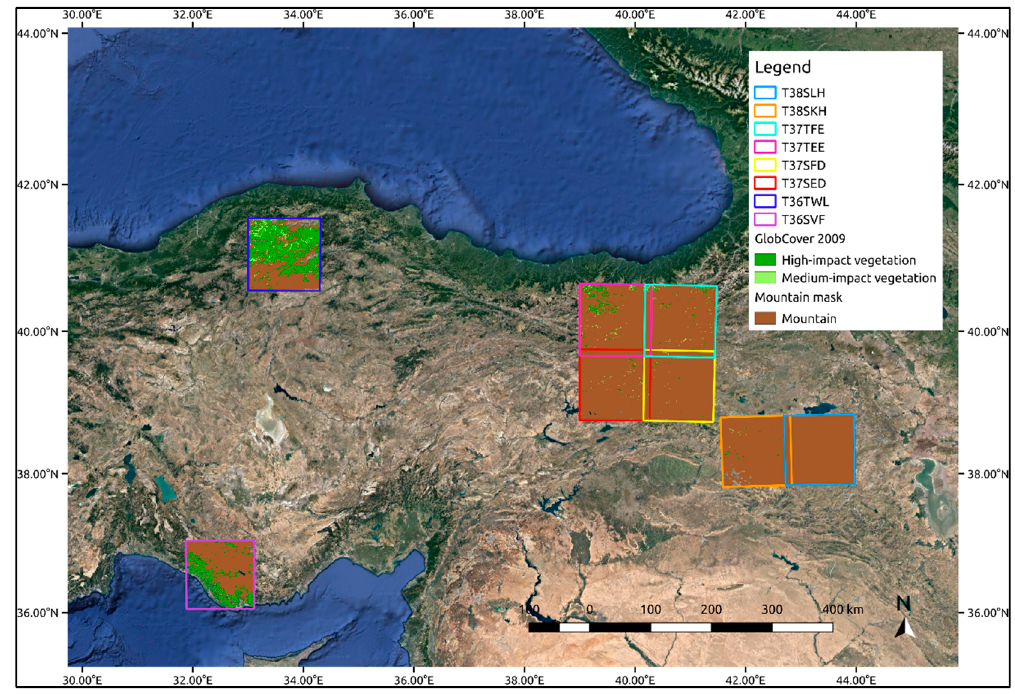
Figure 6. Selection of S-2 tiles in Turkey.